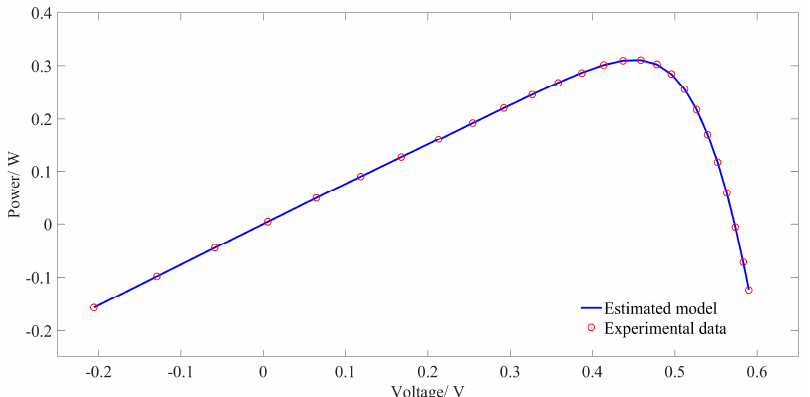
Figure 7. Comparison of estimated model and experimental data PV characteristics of single diode model by HPSOSA.